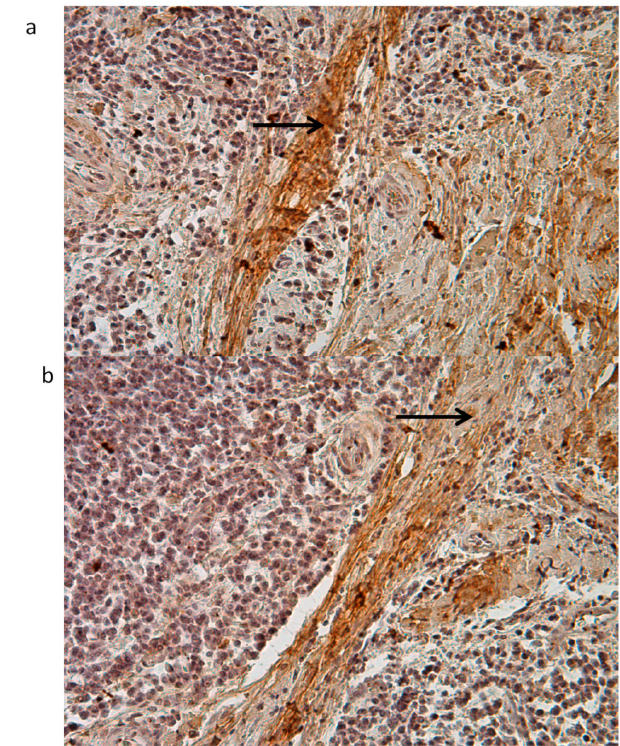
Figure 9. Immunohistochemistry against collagen fibers in PI samples (black arrows) (20 × ). Collagen fibers in PI samples ( a , b ) were often free of cell (black